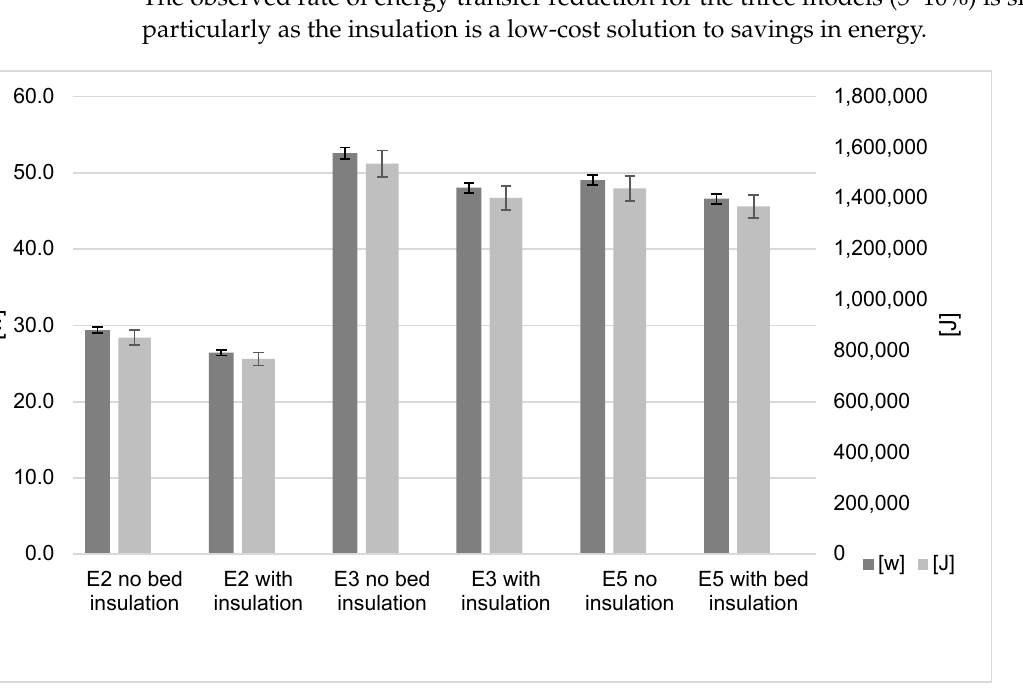
Figure 3. Heated Bed influence on energy results.